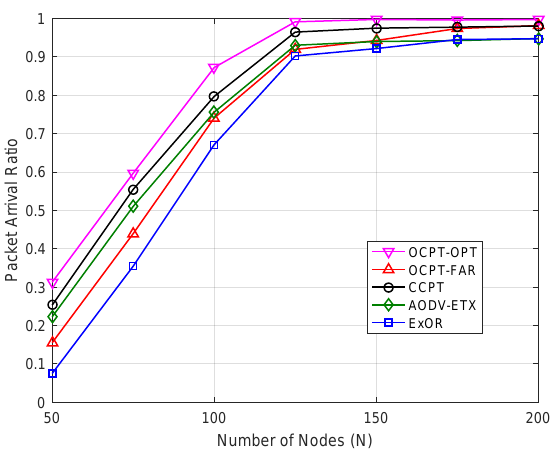
Figure 3. Packet arrival ratio vs. number of nodes with different schemes under the fixed V s and V d